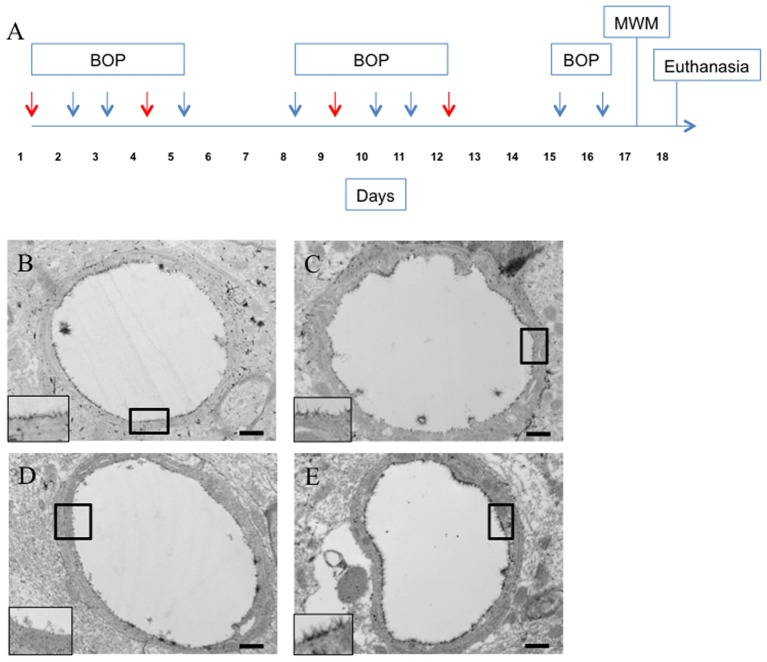
Hyaluronidase infusion increased glycocalyx thickness in sham and blasted rats. Schema representing experimental design for experiment 2 (A). Each arrow represents an individual blast overpressure exposure (BOP) with red arrows denoting days with hyaluronidase infusion. Representative electron micrographs of capillaries from cerebral cortex taken from blast and sham blasted animals infused with hyaluronidase or vehicle. Capillaries from hyaluronidase infused sham controls (C) and blast exposed (E) rats had qualitatively thicker glycocalyx when compared to saline infused sham controls (B) or blast exposed (D) animals. All insets represent magnified image; scale bar = 500 nm.